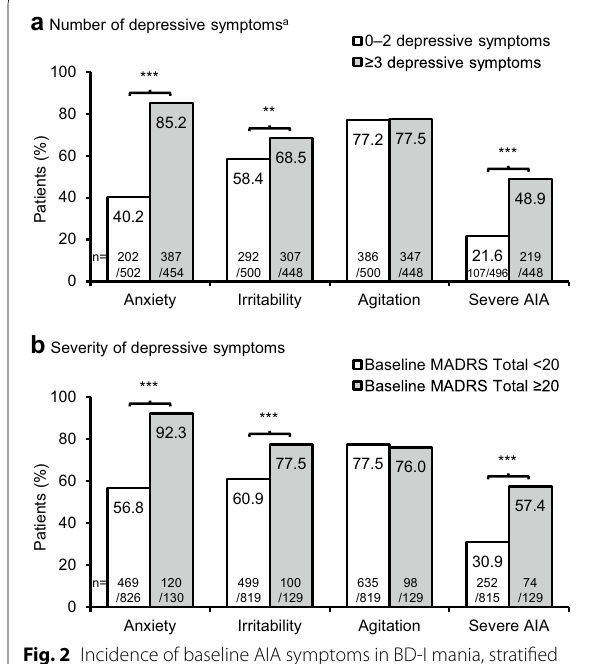
Fig. 2 Incidence of baseline AIA symptoms in BD-I mania, stratified by the number/severity of depressive symptoms. ** p < 0.01, *** p < 0.001, Chi squared test. Anxiety was defined as a PANSS